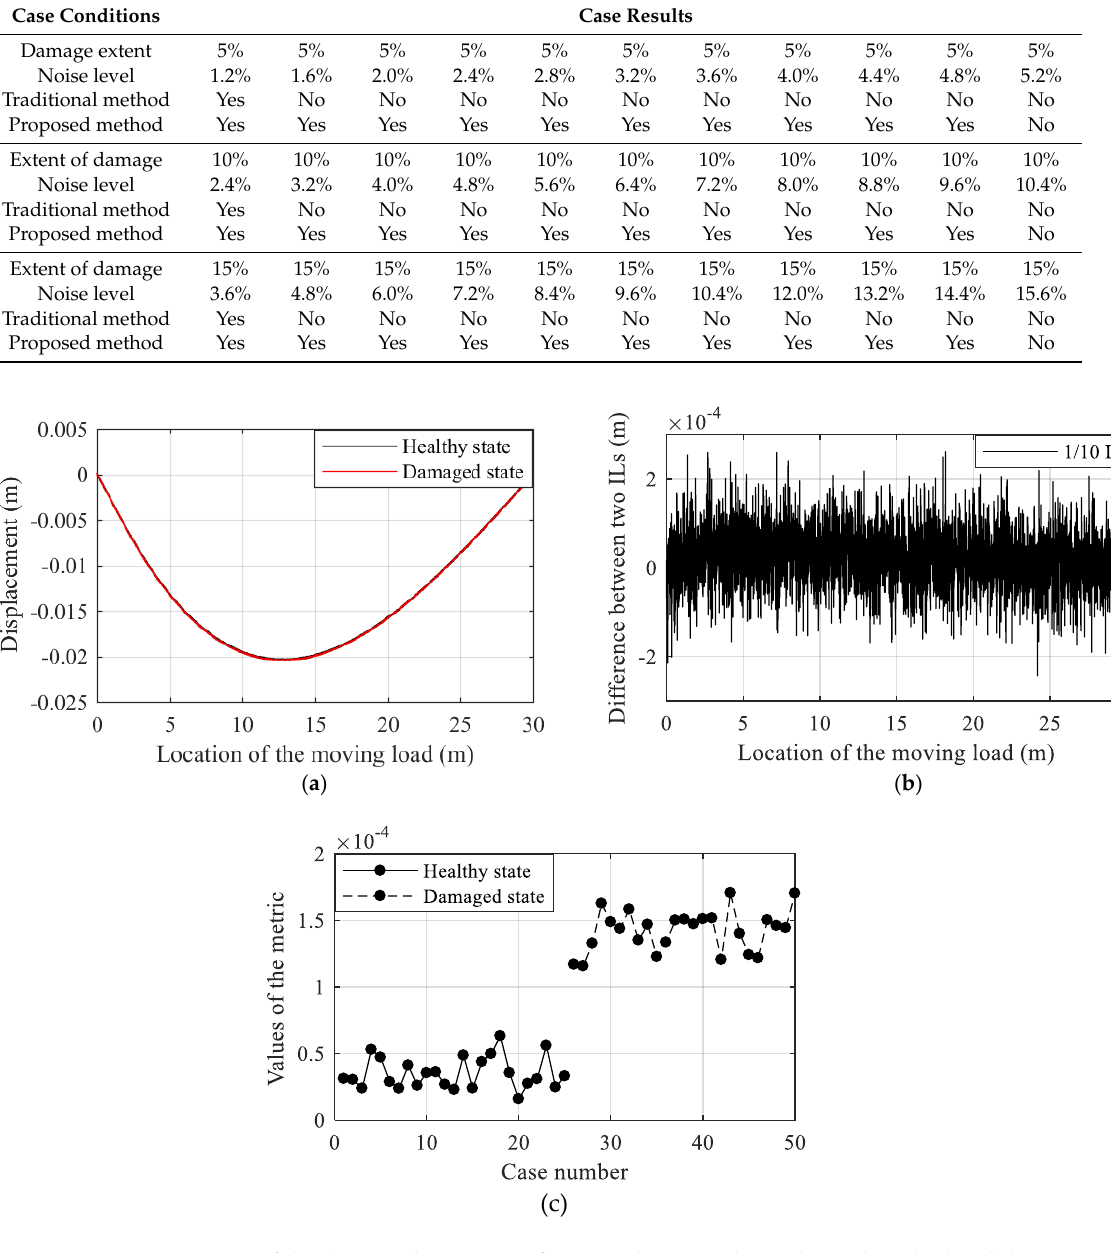
Figure 7. Comparison of the damage detection performance between the traditional method and the proposed method before and after damage with a 1.6% noise level: ( a ) displacement ILs; ( b ) difference between two displacement ILs obtained by the traditional method; ( c ) metric of the damage feature obtained by the proposed method.